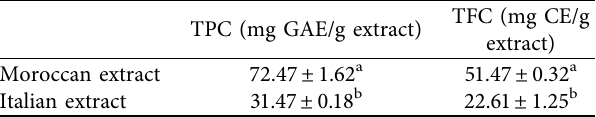
Table 1: Total phenolic and flavonoid contents of C. sativus aqueous